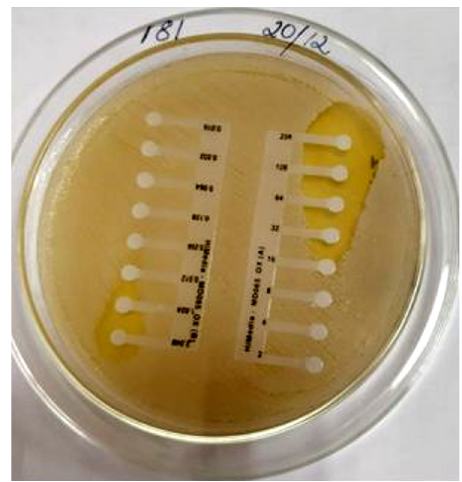
Fig. 4. E Strip method for MIC, for oxacillin using Hi Comb MIC